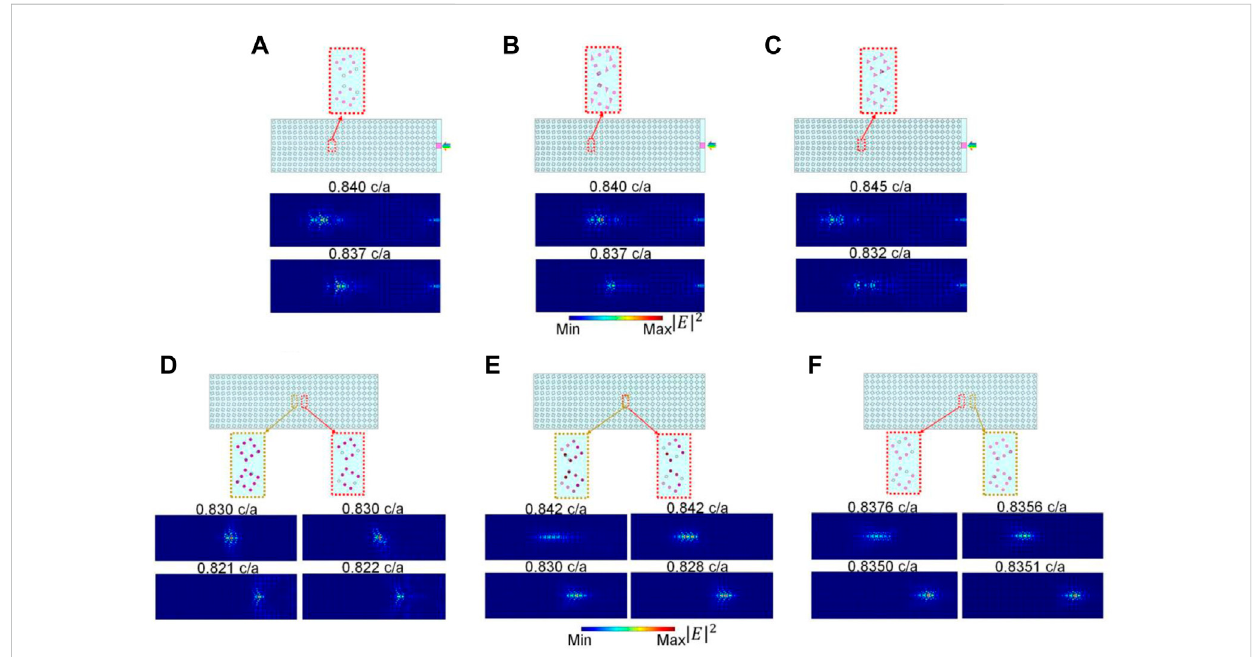
FIGURE 4 Defects and disorders are introduced in the structures, as shown in the dotted boxes. The black dashed graphics are the original appearance of pillars. (A – C) are the three cases of the Hermitian system. The pillar ’ s shapes and disturbances are both different between them. (D – F) are the non- Hermitian cases, which are the results of introducing defects and disorders into the structure mentioned in Section 2.3. Defects are framed in red, and disorders are framed in ginger. The corresponding | E | 2 fi eld distribution diagrams are shown below the detailed